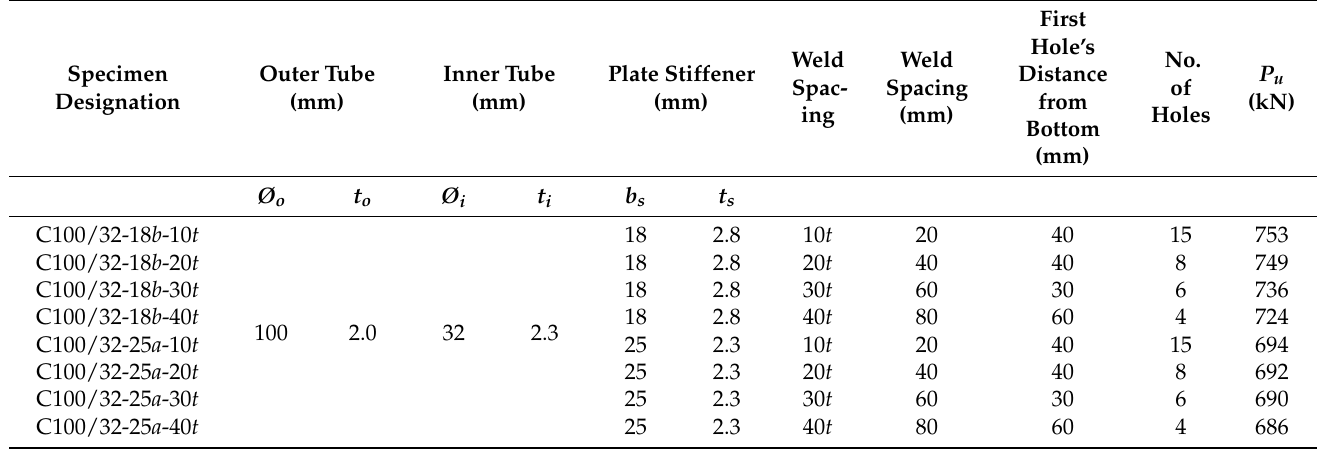
Table 10. Geometric and material properties of the stiffened circular CFDST stub column for the parametric